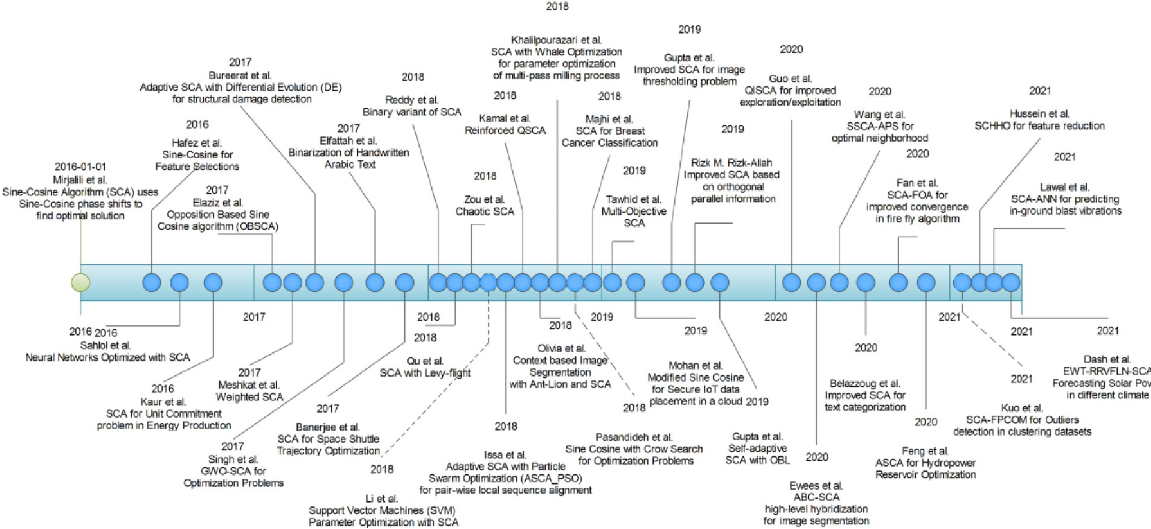
Fig 1. Some of the major contributions on SCA since its